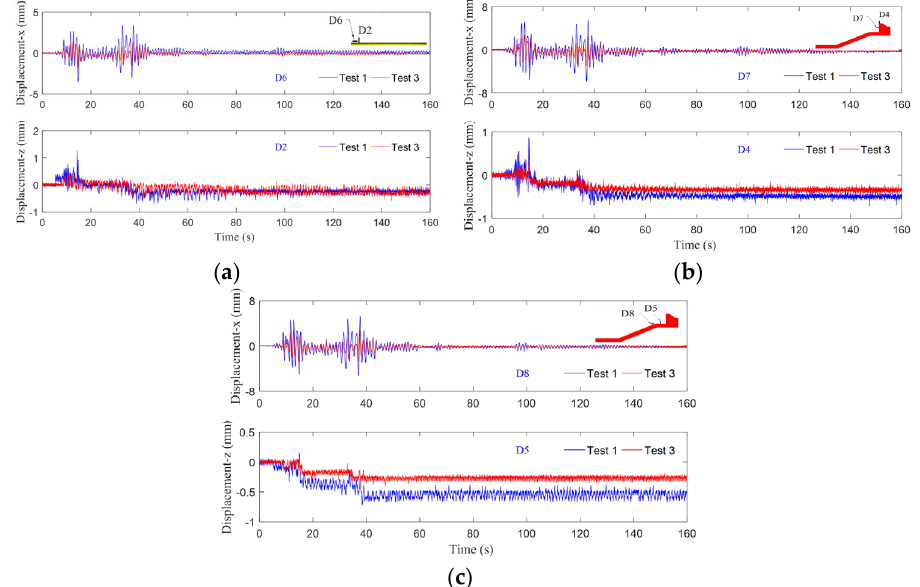
Figure 16. Comparisons of displacement responding at typical positions in Test 1 and Test 3. ( a ) Runway. ( b ) Caisson. ( c ) Revetment.